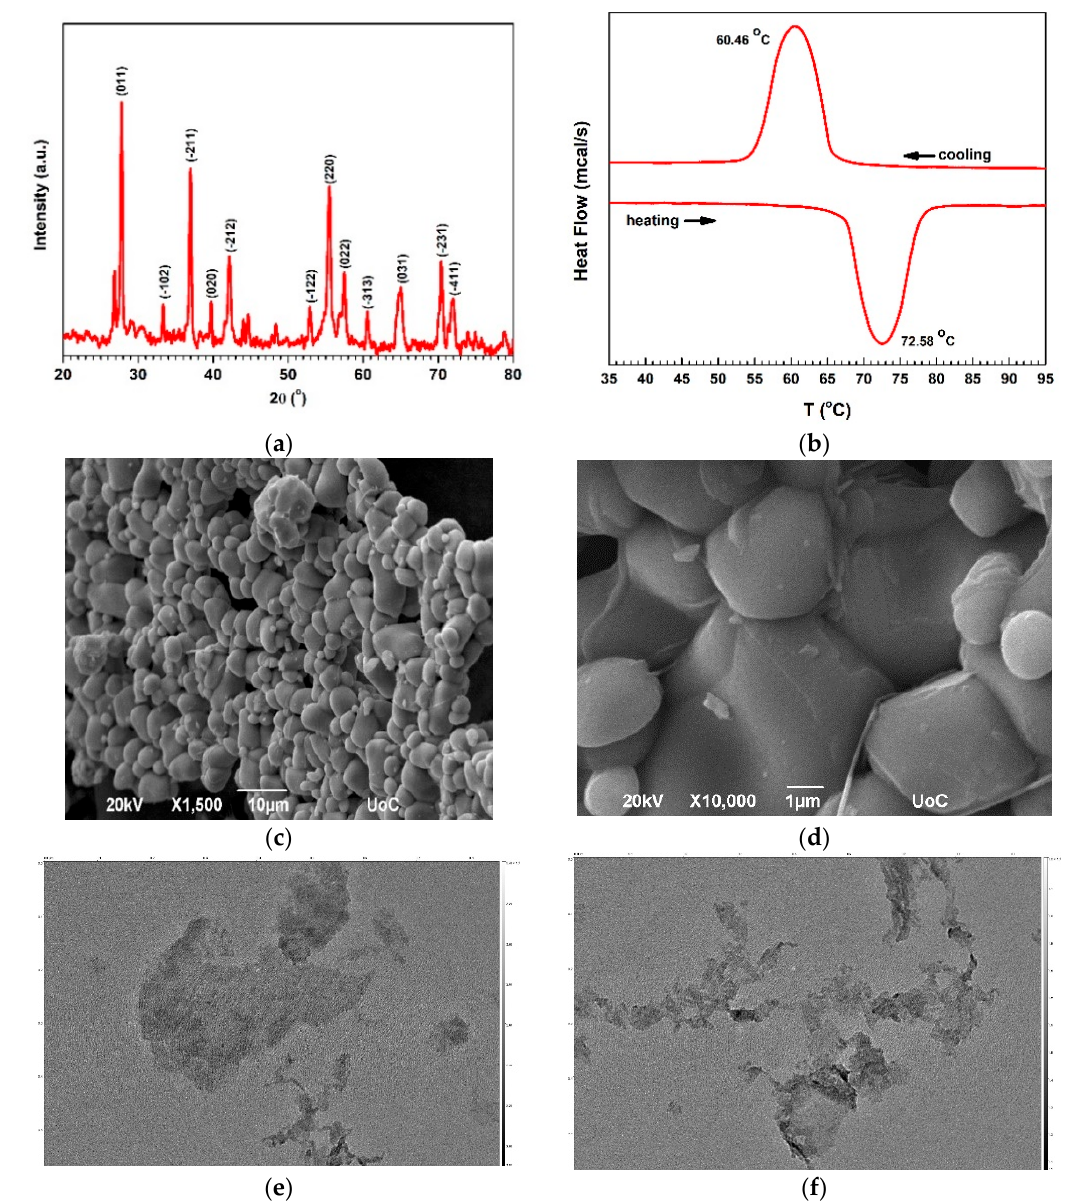
Figure 1. ( a ) XRD pattern; ( b ) differential scanning calorimetry (DSC) curve; ( c , d ) SEM images, and ( e , f ) TEM images of VO 2 powder particles.